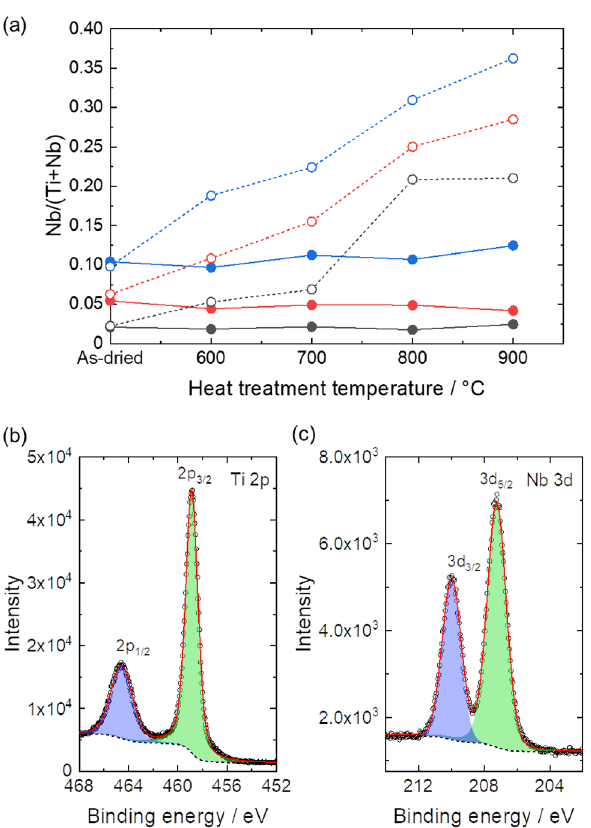
Figure 4. ( a ) Nb/(Ti + Nb) values calculated from SEM–EDS (filled symbol with solid lines) and XPS (open symbol with dot lines) spectra of NTO-2- y (black), NTO-5- y (red) and NTO-10- y (blue). ( b ) Ti 2p and ( c ) Nb 3d XPS spectra of NTO-5–600 (open circles, black dot line, blue/green area, and red solid line denote experimental data, background, fitted curves, and cumulative curves of fitted